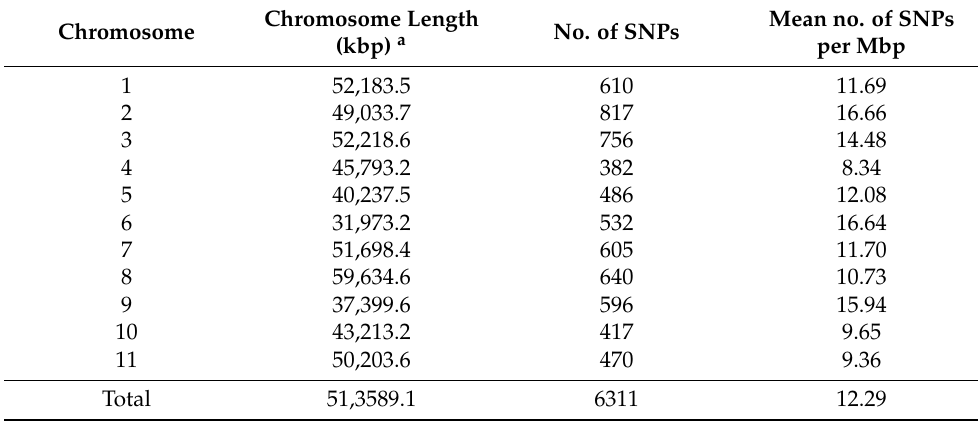
Table 1. Distribution of high-quality DArTseq-derived SNPs on common bean